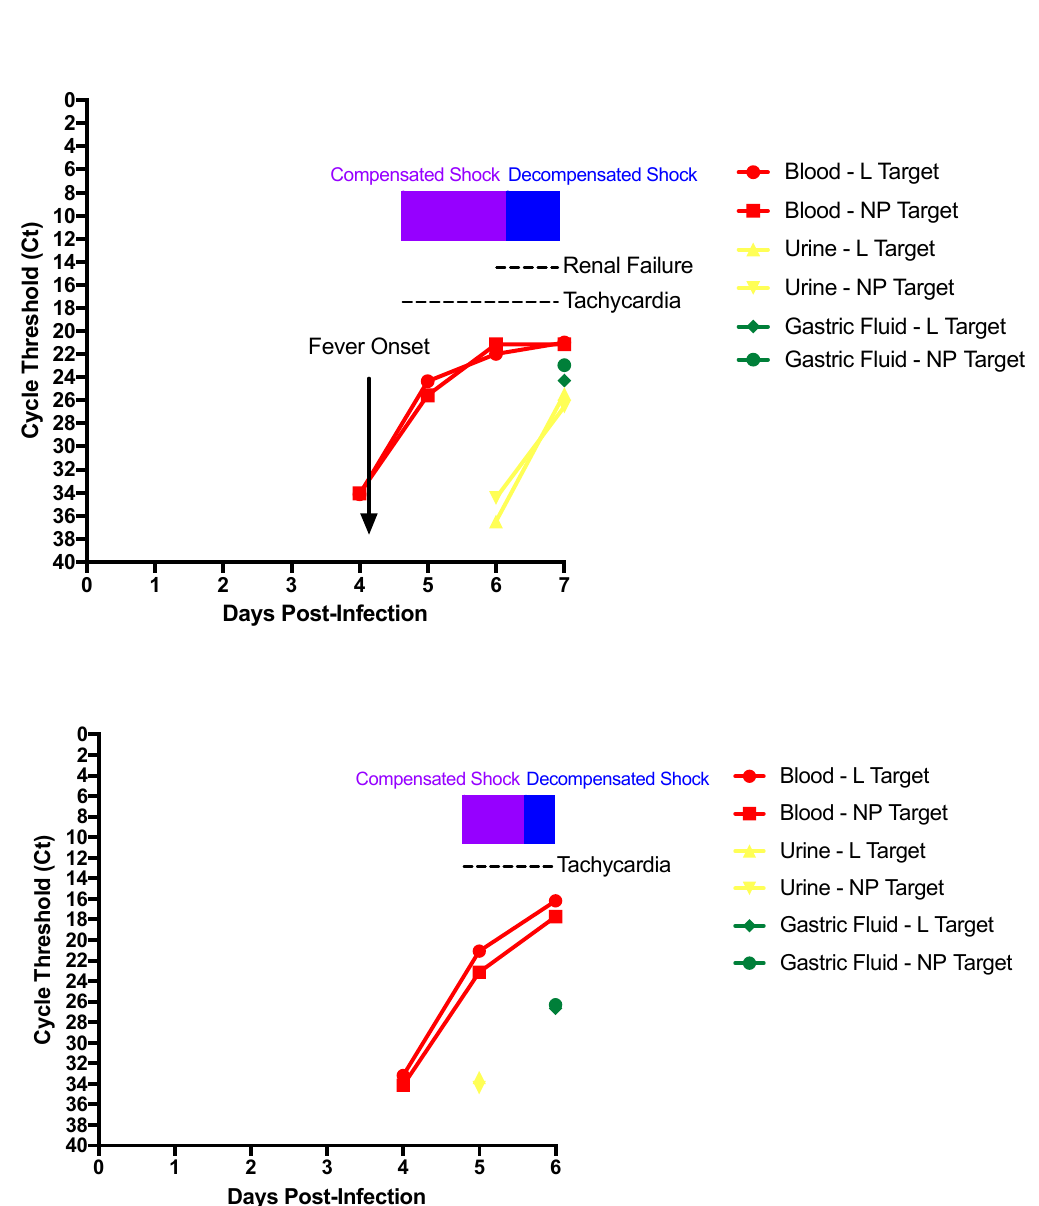
Figure 2. Detection of viral RNA in blood and body fluids during EVD. Blood, urine, and gastric residuals were collected 1–2 weeks before study initiation, and daily throughout the course of clinical disease. All samples were extracted, reverse transcribed, and then quantified using two targets for EBOV RNA quantification, blood L-gene ( • ) and NP- targets ( (cid:4) ), urine L-gene ( (cid:78) ) and NP- targets ( (cid:72) ), and gastric residuals L-gene ( (cid:7) ), and NP-targets ( • ) for ( A ) NHP 1 and ( B ) NHP